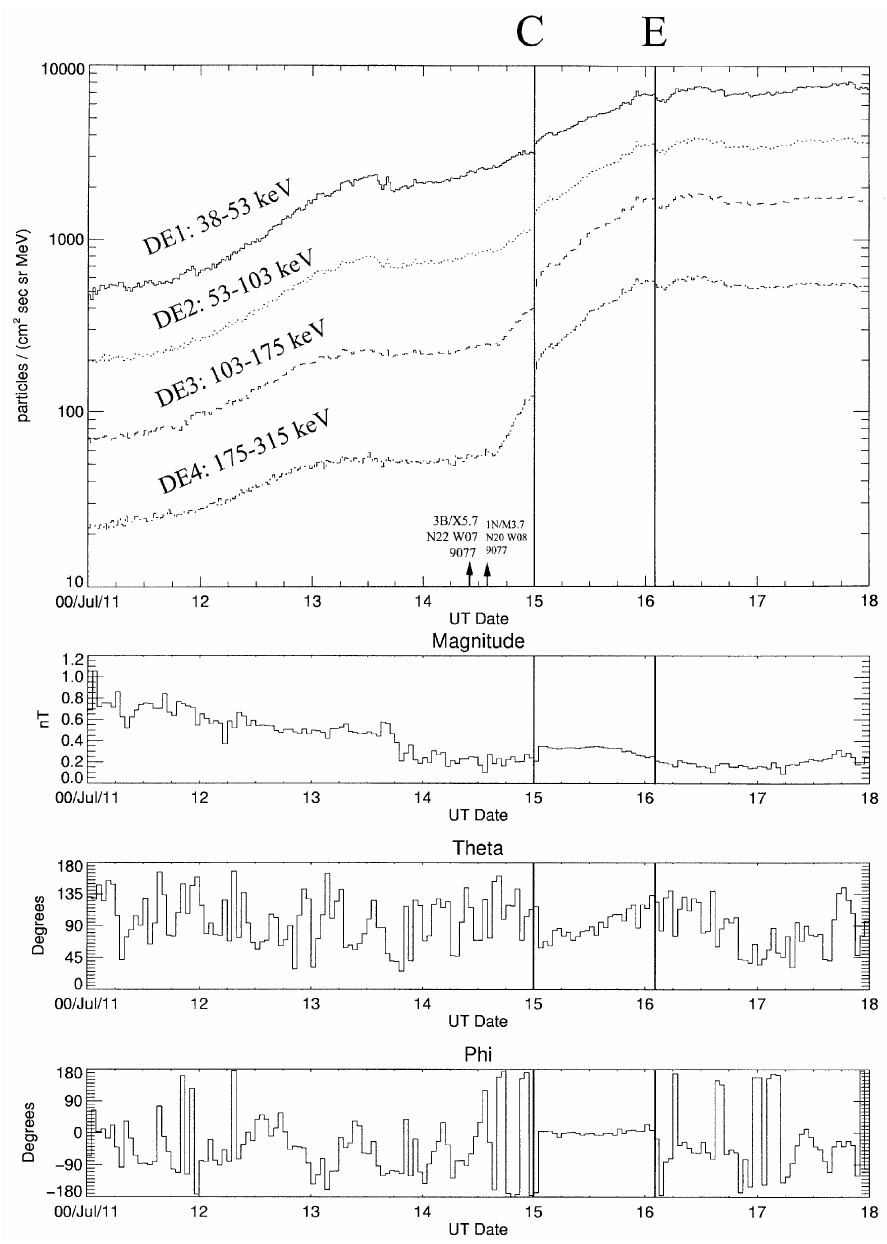
Fig. 5. ULYSSES energetic electron and magnetic field data in the vicinity and during the traversal of the ICME observed in July 2000. An abrupt and discontinuous increase in the particle intensities is observed upon entry of ULYSSES inside the ICME.